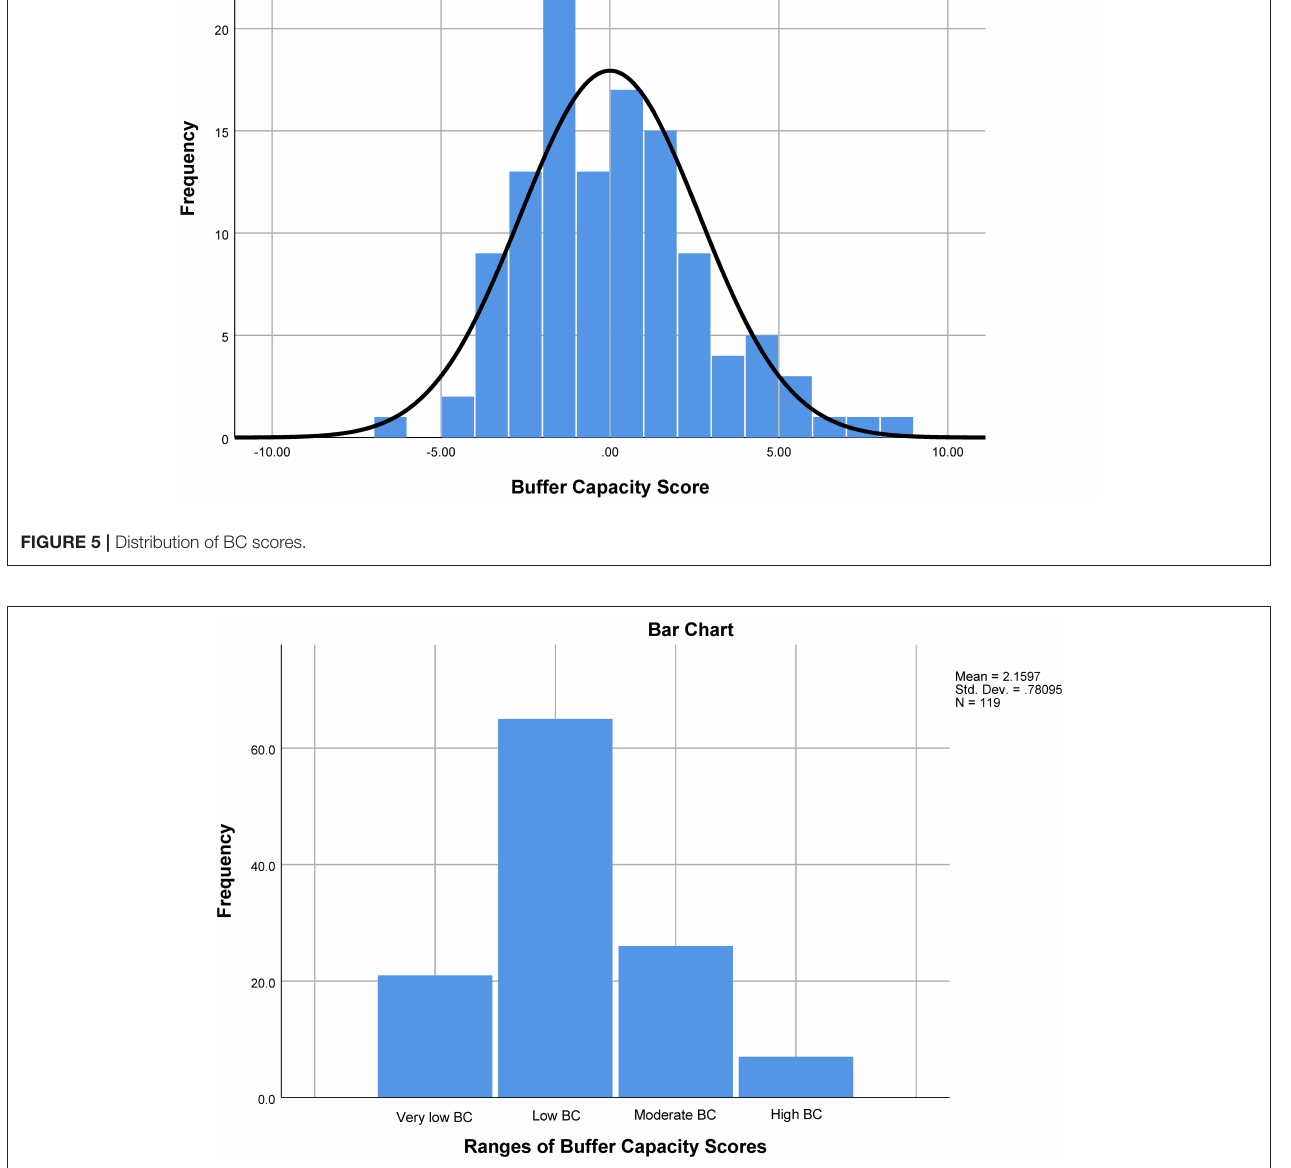
FIGURE 6 | Frequency of BC scores